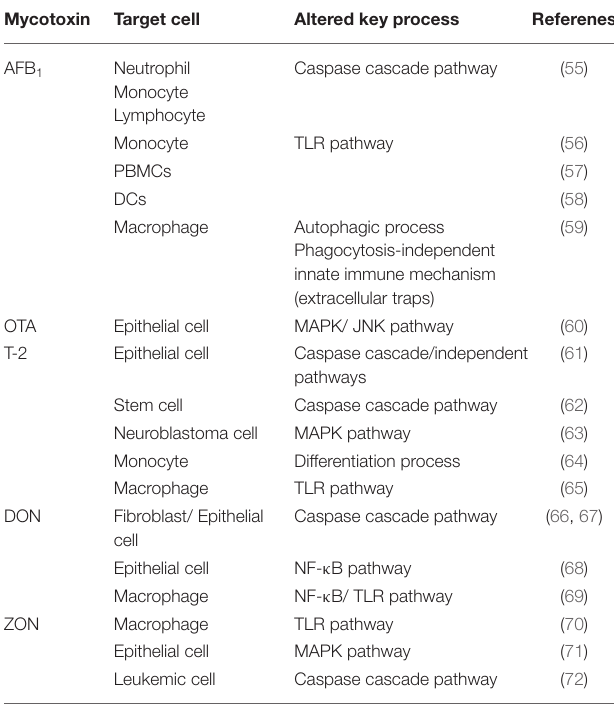
TABLE 2 | The summarized list of stress-related immune pathways modulated by mycotoxins at very low doses; with possibly toxic action at the vascular level. Mycotoxin Target